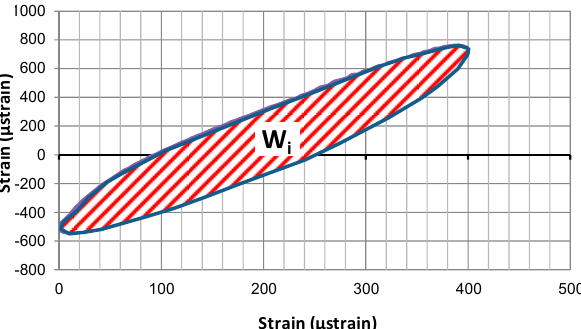
Figure 6. The area within the hysteresis loop in a given period (50th cycle) of the fatigue test, reflecting the energy dissipated in this cycle.